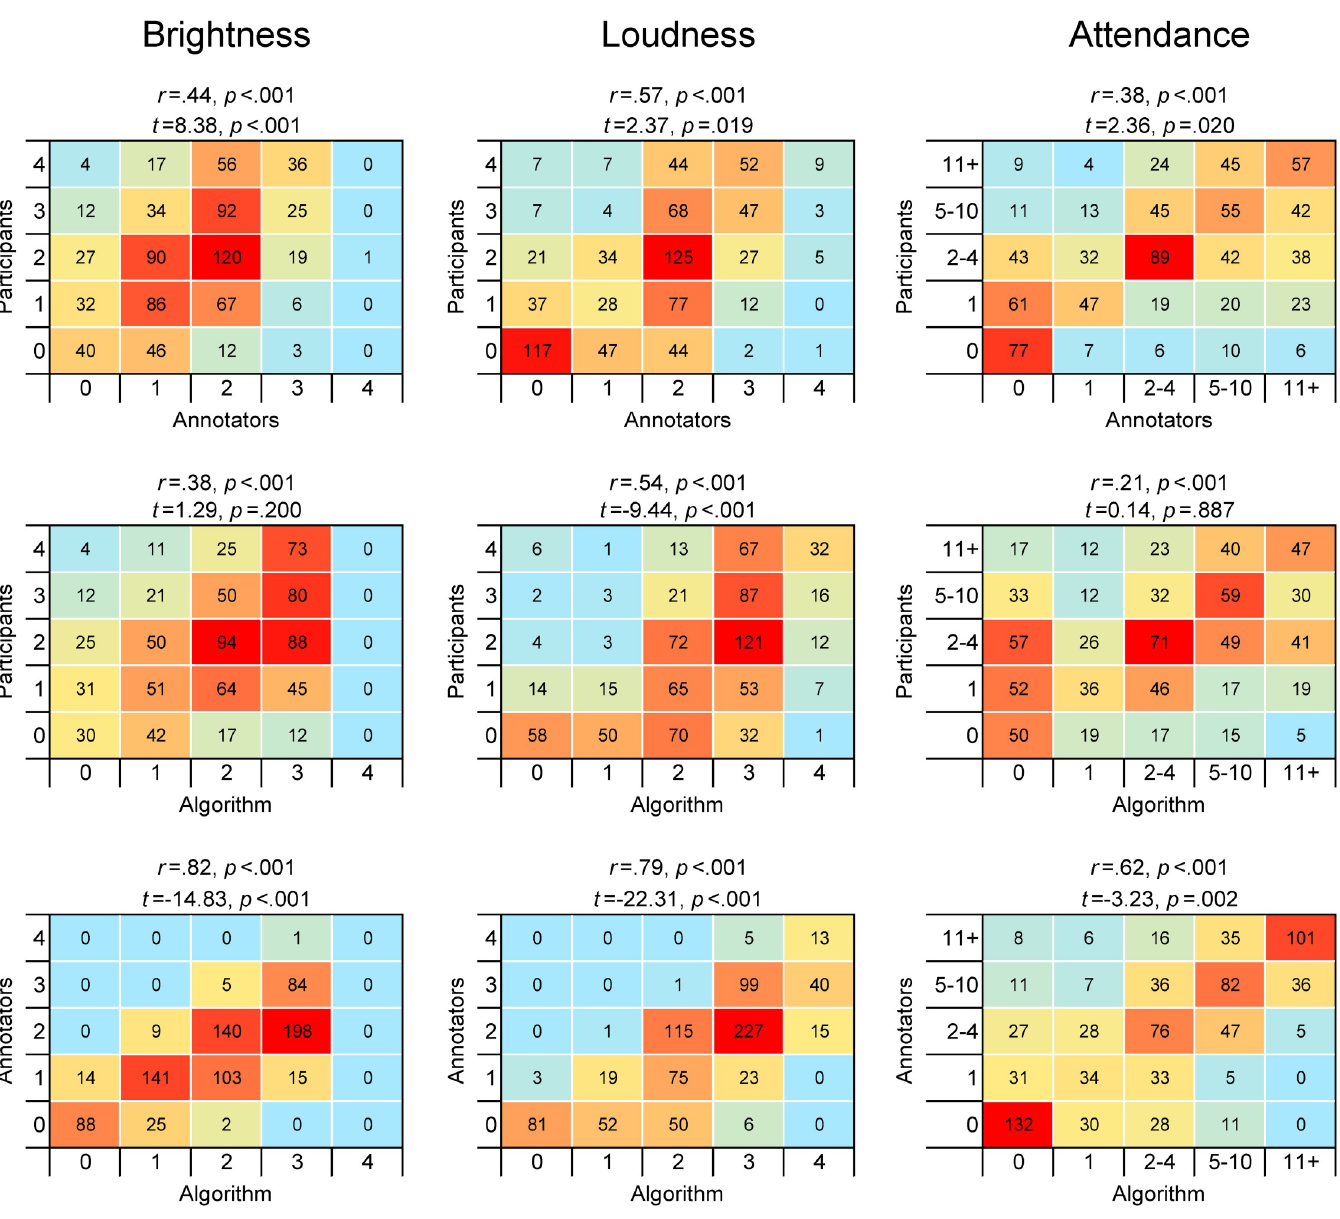
Fig 1. Correspondence matrix, Pearson’s correlations and mean difference tests of participants’, annotators’ and computer algorithms’ ratings of brightness, loudness and attendance in the 825 drinking situations.